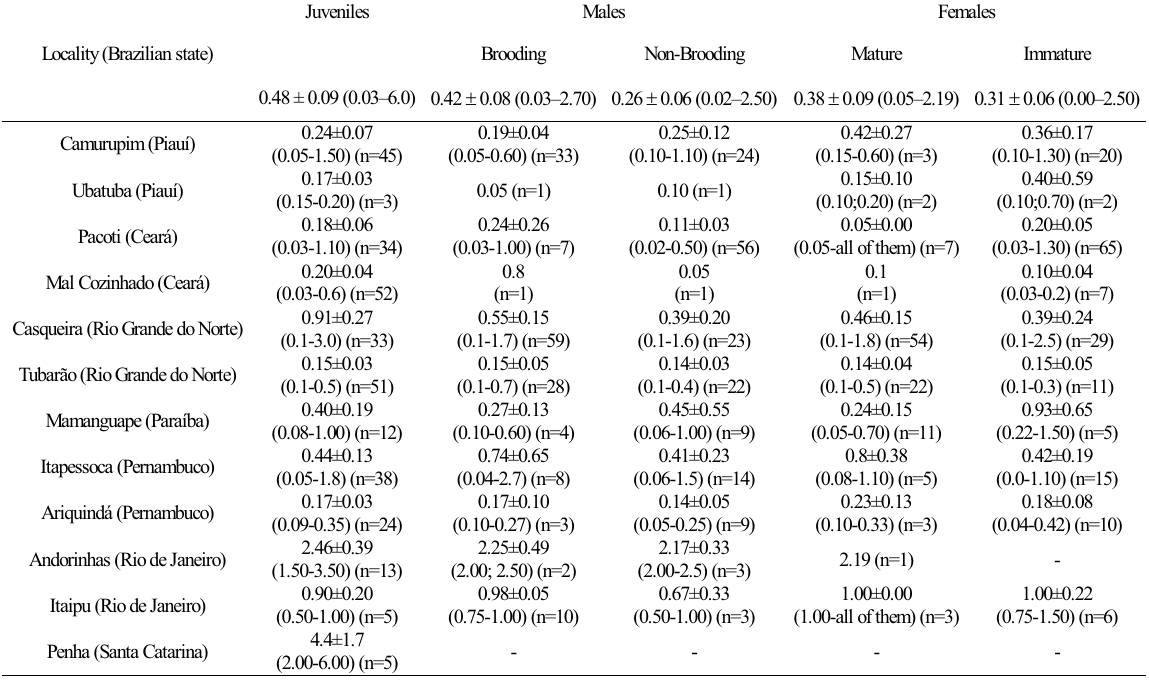
Table 6. Mean, confidence interval and range of depths (m) at which Hippocampus reidi was sighted in 12 Brazilian